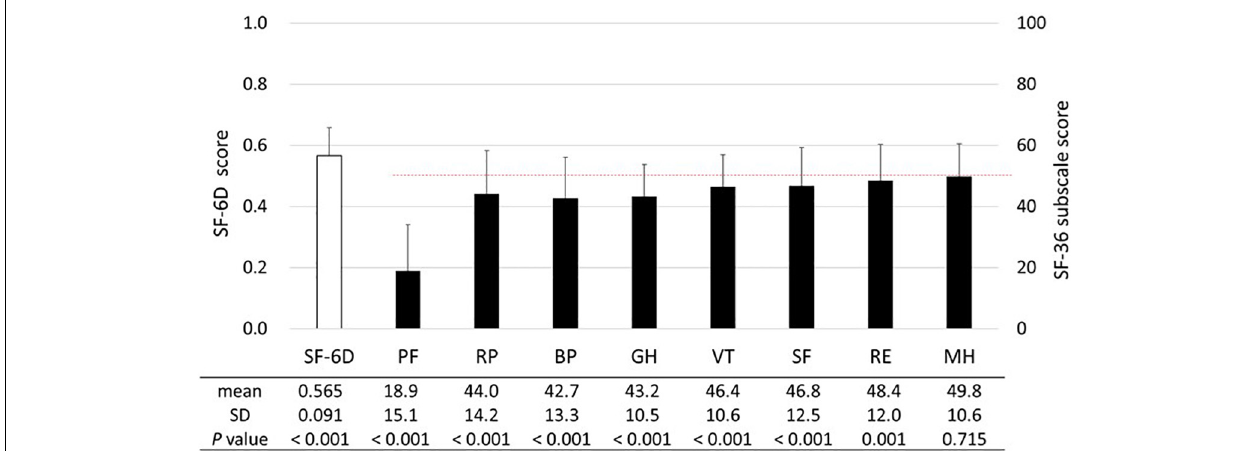
FIGURE 2 | SF-6D and SF-36 subscales. The means and standard deviations (SDs) of the SF-6D and SF-36 subscale scores are presented ( n = 538). The dashed line (50 points) represents the mean SF-36 subscale score among the general Japanese population. The unpaired t -test was used to compare the SF-6D score of patients with HAM to the national population norm reported by Shiroiwa et al. [mean (SD) score in the 60–69 years age: 0.674 (0.128)] (23). The SF-36 subscale scores were compared with the national standard of 50 using the one-sample t -test. Abbreviations of SF-36 subscales: BP, bodily pain; GH, general health perception; MH, mental health; PF, physical functioning; RE, role emotional; RP, role physical; SF, social functioning; VT, vitality.